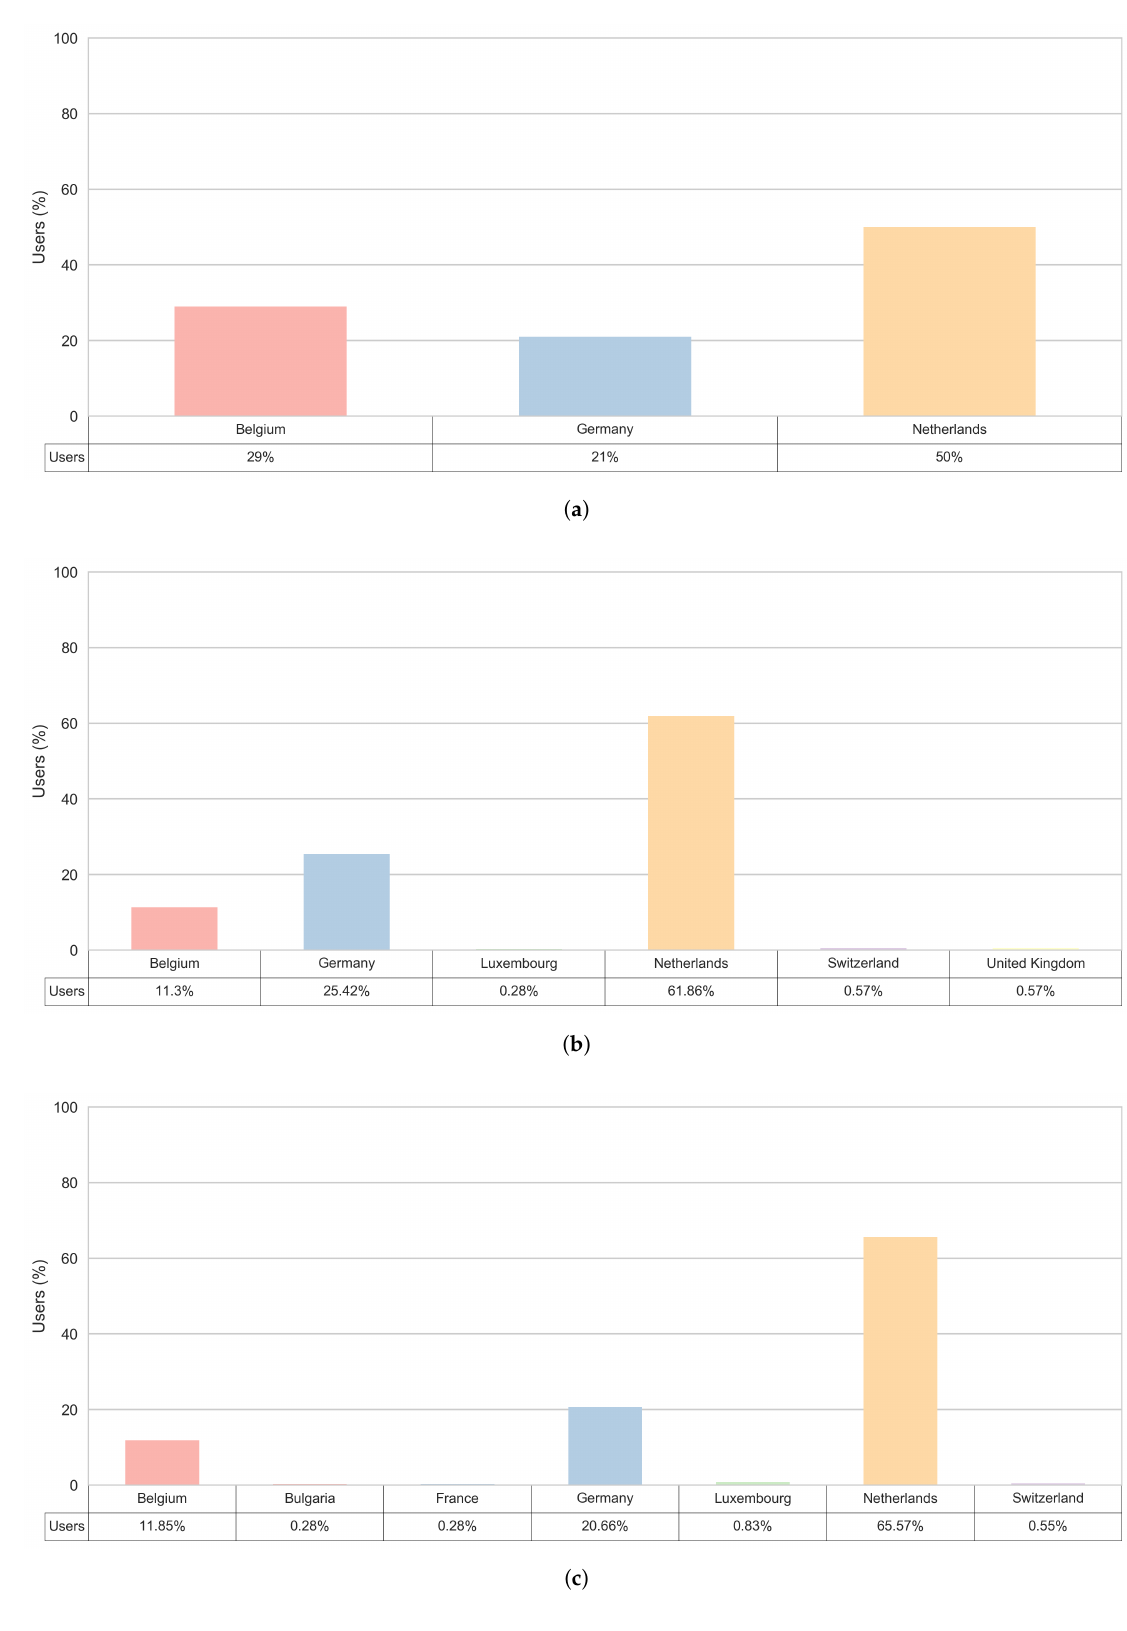
Figure 12. Country of the origin for trips that end in the Zeeland region. ( a ) External 24; ( b ) External long; ( c ) External